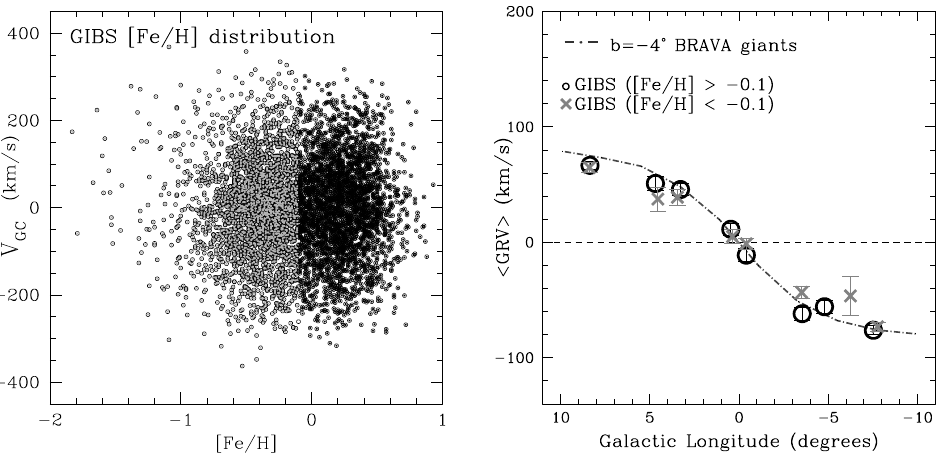
Figure 6. ( Left ) Metallicity versus Galactocentric velocity for the GIBS sample. A division between sub-solar ( [ Fe/H ] < − 0.1 dex) and solar ( [ Fe/H ] > − 0.1 dex) samples can be seen. ( Right ) The Galactocentric velocity versus longitude distribution at fixed latitudes, split up into sub-solar (grey) and solar (black) samples. There is no statistical difference in kinematics between these two metallicity